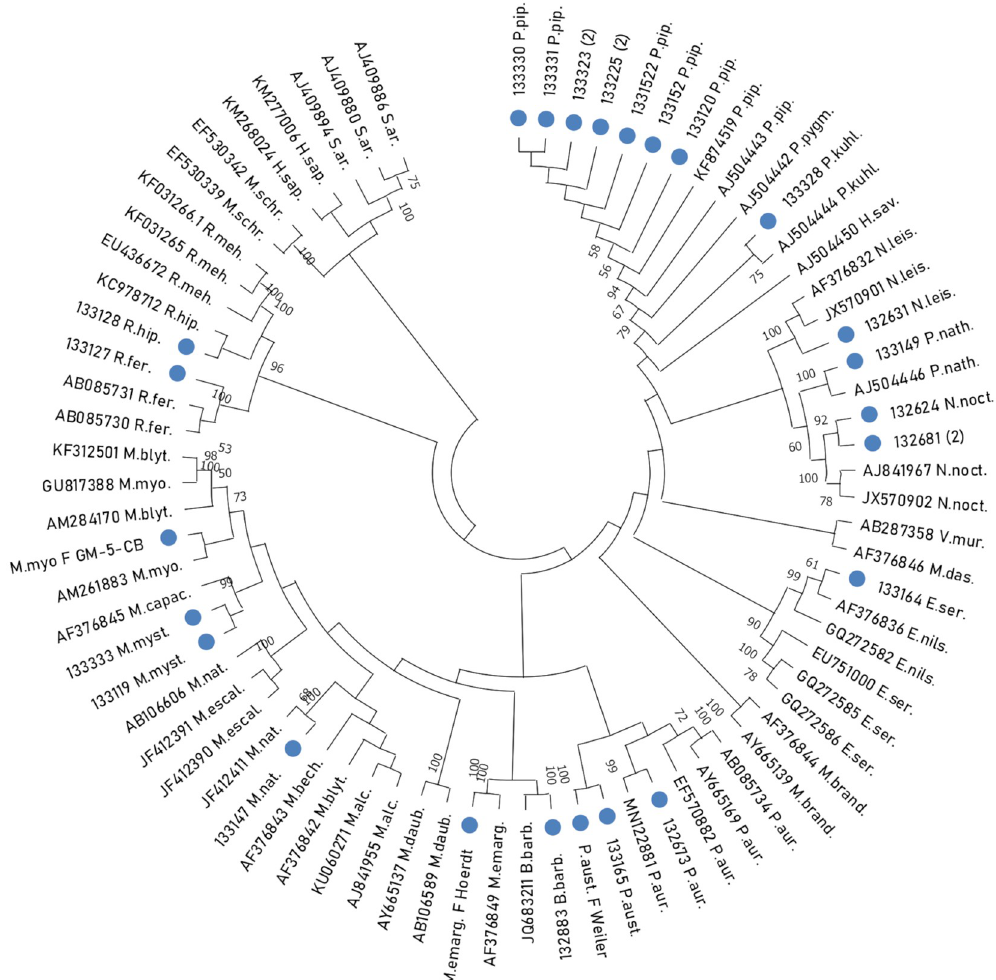
Fig 1. Phylogenetic tree of the partial cytochrome b (cyt b) gene of 52 referenced sequences and 25 bat sequences representing 15 autochthonous bat species. B.barb : Barbastella barbastellus , E.nils : Eptesicus nilssonii , E.ser : Eptesicus serotinus , H.s : Homo sapiens , H.savi : Hypsugo savii , M.al : Myotis alcathoe , M.bech : Myotis bechsteinii , M.bly : Myotis blythii , M.br : Myotis brandtii , M.c : Myotis capaccinii , M.daub : Myotis daubentonii , M.das : Myotis dasycneme , M.em : Myotis emarginatus , M.esc : Myotis escalerai , M.myo : Myotis Myotis , M.mys : Myotis mystacinus , M. nat : Myotis nattereri , M.schr : Myotis schreibersii , N.leis : Nyctalus leisleri , N.noct : Nyctalus noctula , P.aur : Plecotus auritus , P.aust : Plecotus austriacus ,